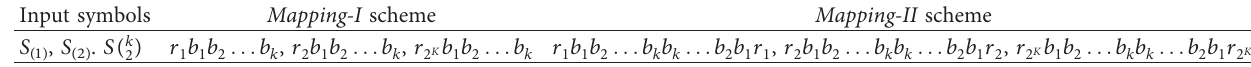
Table 2: Different combinations of Mapping-I and Mapping-II